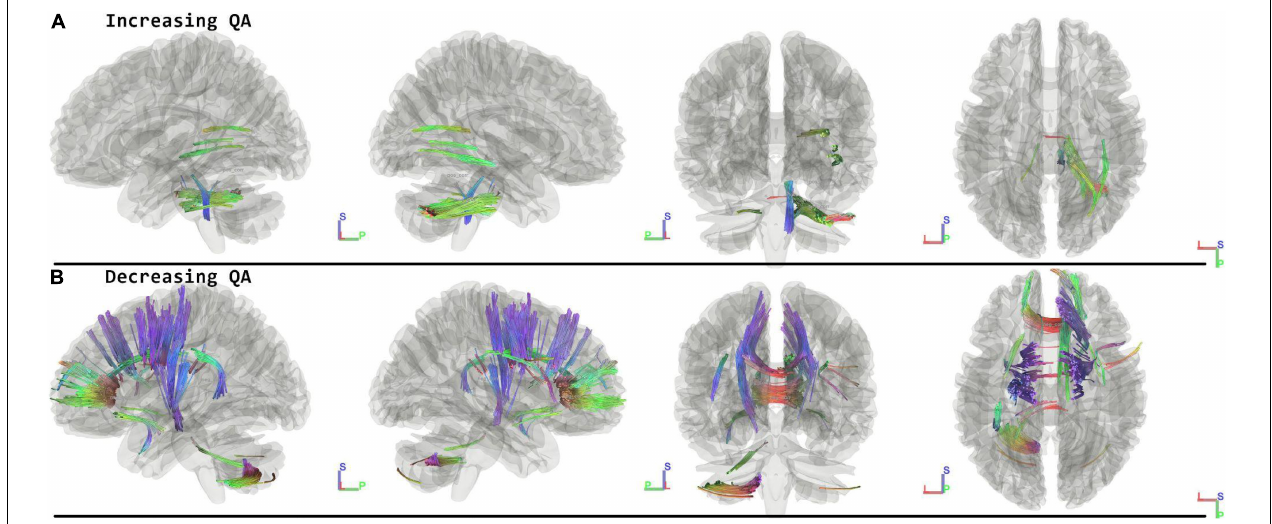
FIGURE 2 | Tracts Associated with changes post minus preflight. Increasing quantitative anisotropy (QA) shows tracts increasing in the middle cerebellar peduncle, lemniscus, and corpus callosum (FDR = 0.0033) (A) . Decreasing QA shows changes in the frontal lobes, corpus callosum, and cerebellum (FDR = 0.0009) (B) . Blue indicates superior – inferior. Green indicates anterior – posterior. Red indicates left –